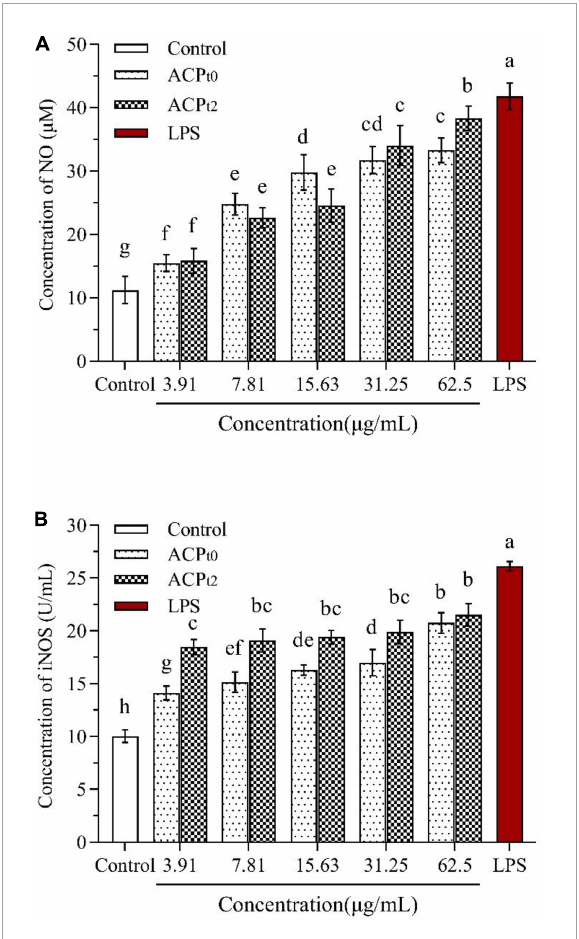
FIGURE6 Effects of ACP t 0 and ACP t 2 on NO secretion (A) , the activity of iNOS (B) in macrophages. The different letters in the column indicate statistically significant differences ( P <